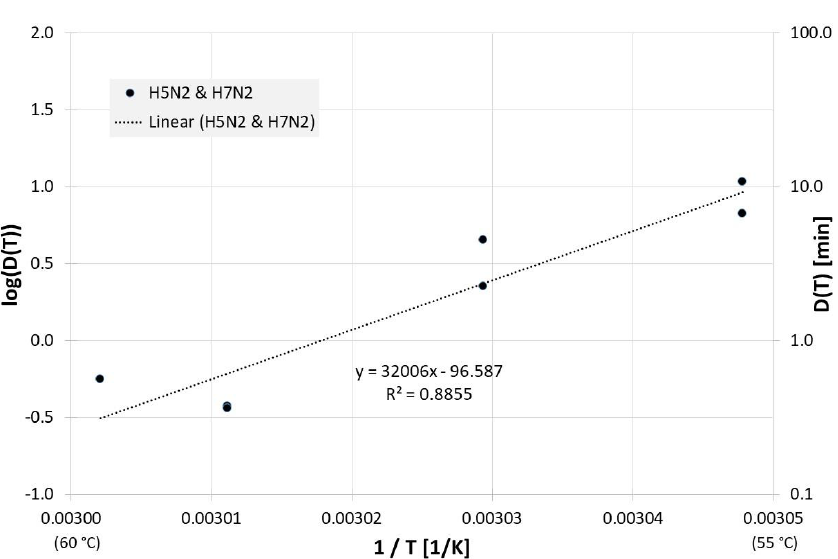
Figure 7. Correlation between 1/T and log(D(T)) for all published influenza virus thermal inactiva- tion data in homogenized whole egg along with the linear regression curve. For better understand- ing, D(T) is also given on the right Y-axis in a logarithmic scale.